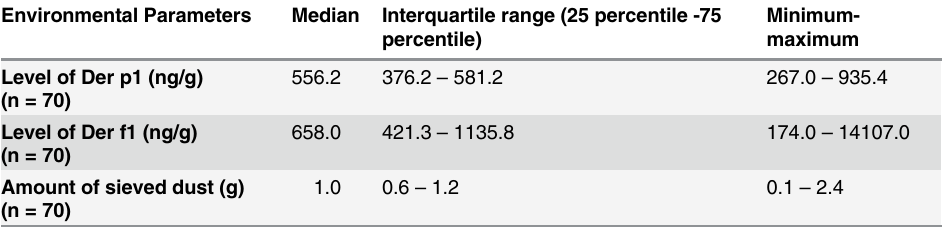
Table 4. Office environment and HDM allergens in the dust samples of 35 office rooms. Environmental